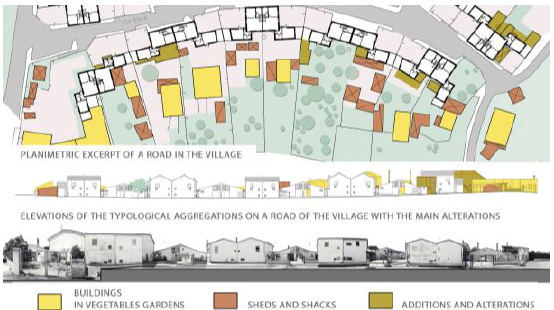
Figure 3. Onsite surveys of the main urban and building modifications (new buildings in vegetable plots, sheds and shacks, additions and alterations ) in the settlement.